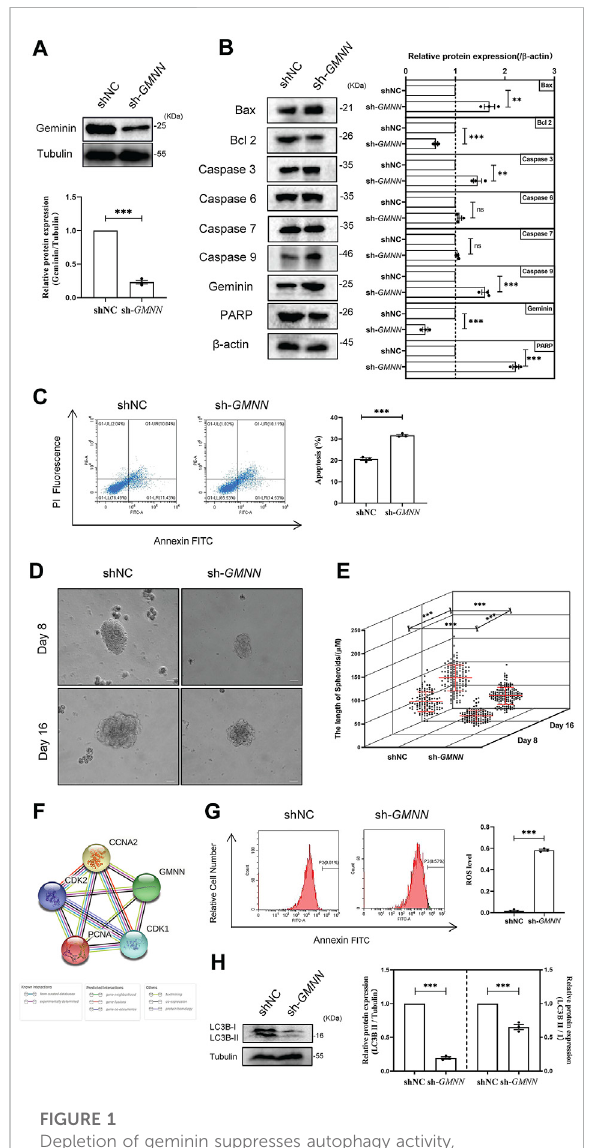
FIGURE 1 Depletion of geminin suppresses autophagy